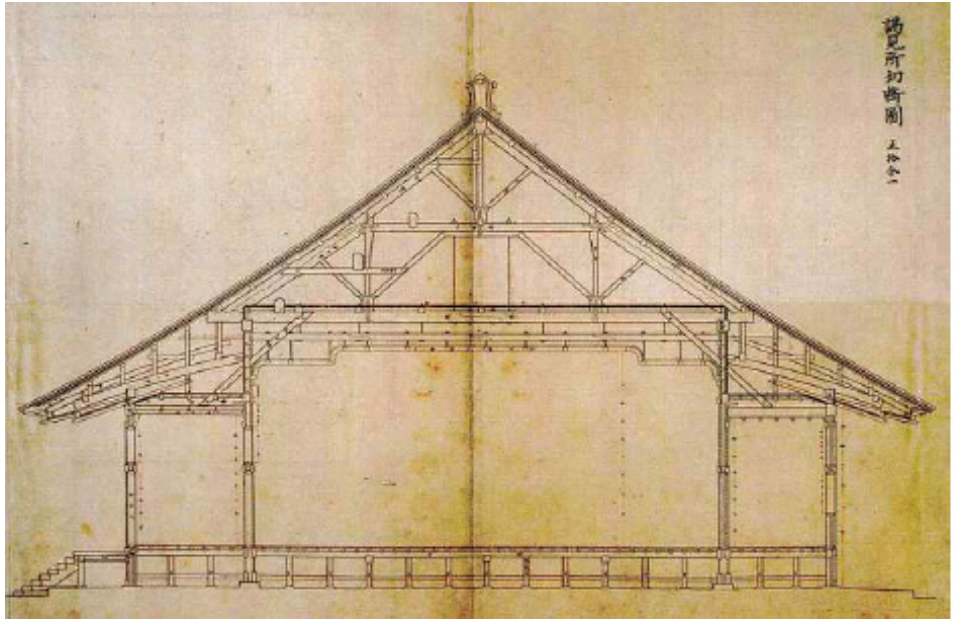
Figure 20. Japanese–Western Style Hybrid Structure Shown in the Meiji Palace Main Hall [23].